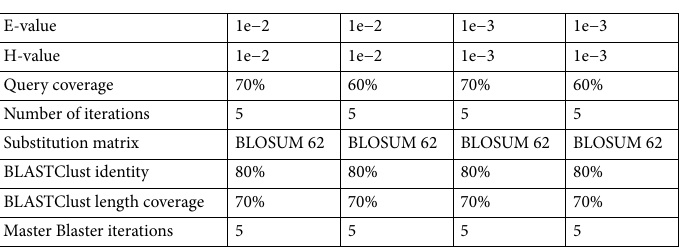
Table 1. Program parameters used for comparative assessment studies of PSI-BLAST, Master Blaster and